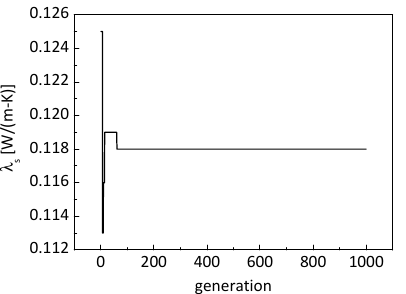
Figure 8. Evolution of identified thermal conductivity of nanometer-sized solid skeletons.